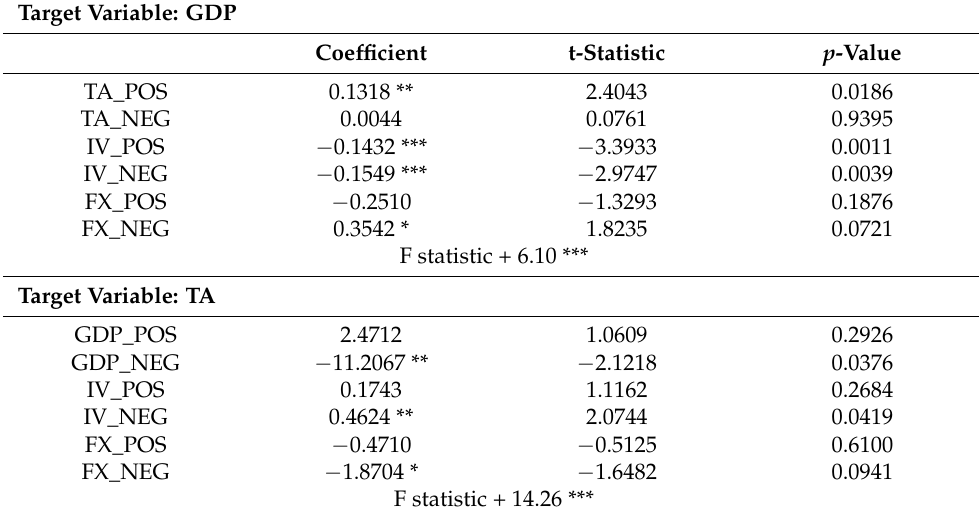
Table 6. Long-run levels asymmetric test